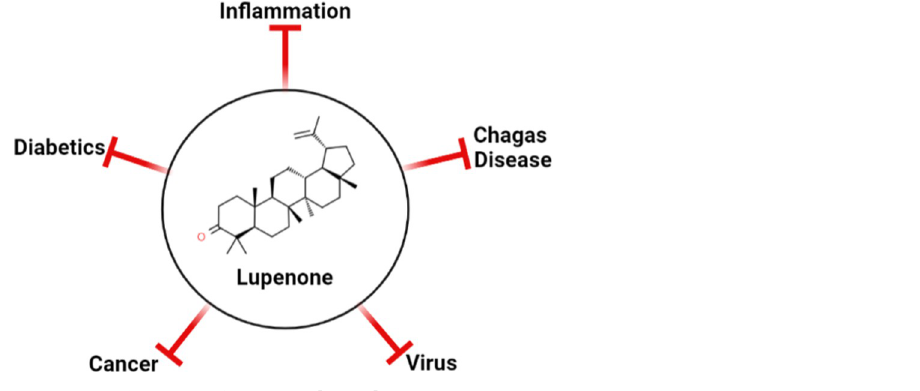
Fig 2. Versatile actions of Lupenone